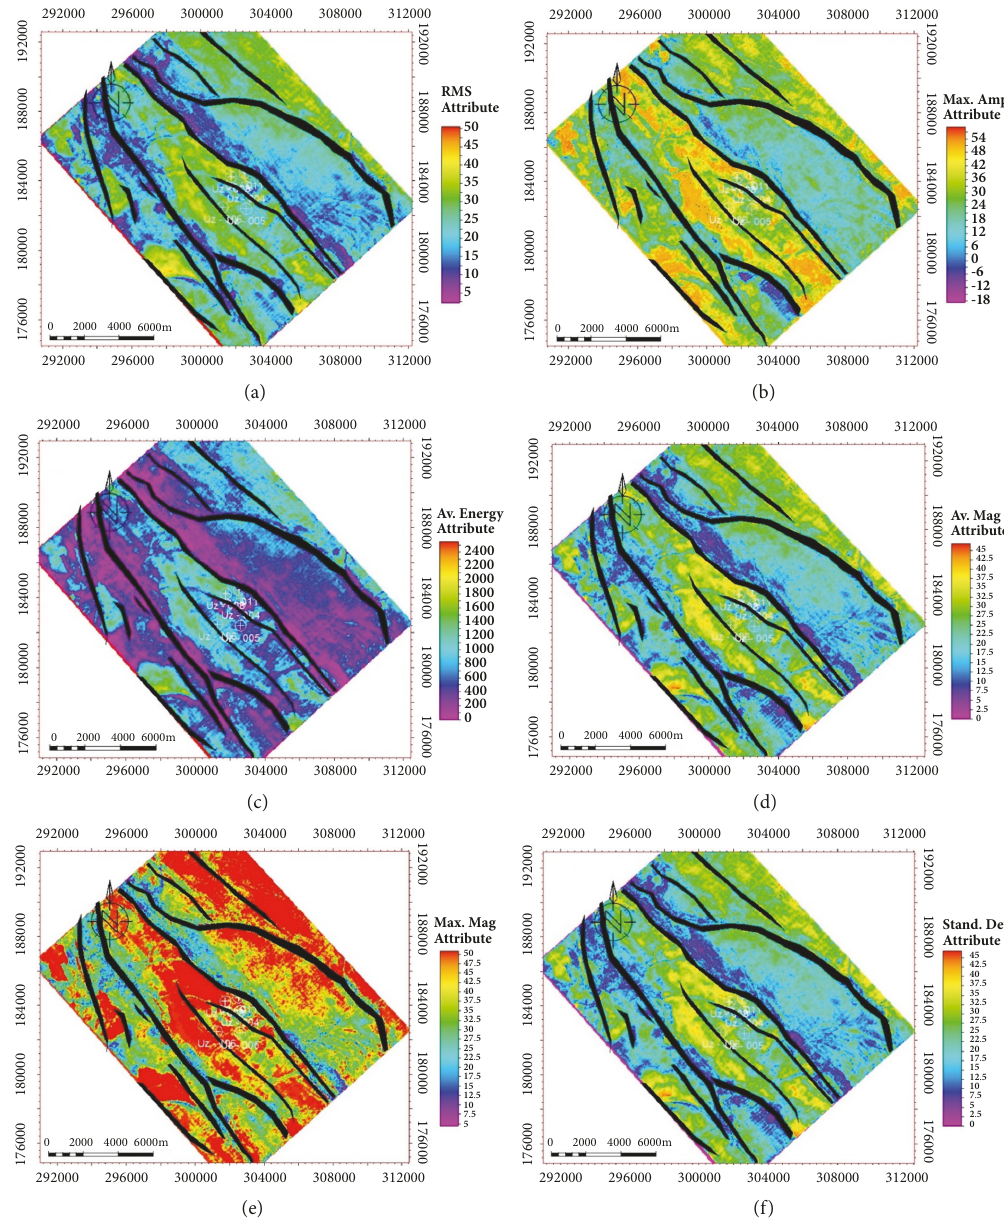
Figure 7: Generatedamplitude mapsD3100reservoirtop.(a)RMS amplitude Attributemapfor D3100reservoirtop.(b)Maximumamplitude attribute map for D3100 reservoir top. (c)Average energy amplitude attributes for D3100 reservoir top. (d) Average magnitude amplitude attributes for D3100 reservoir top. (e) Maximum magnitude attribute map for D3100reservoir top. (f) Standard deviation amplitude attribute map for D3100 reservoir